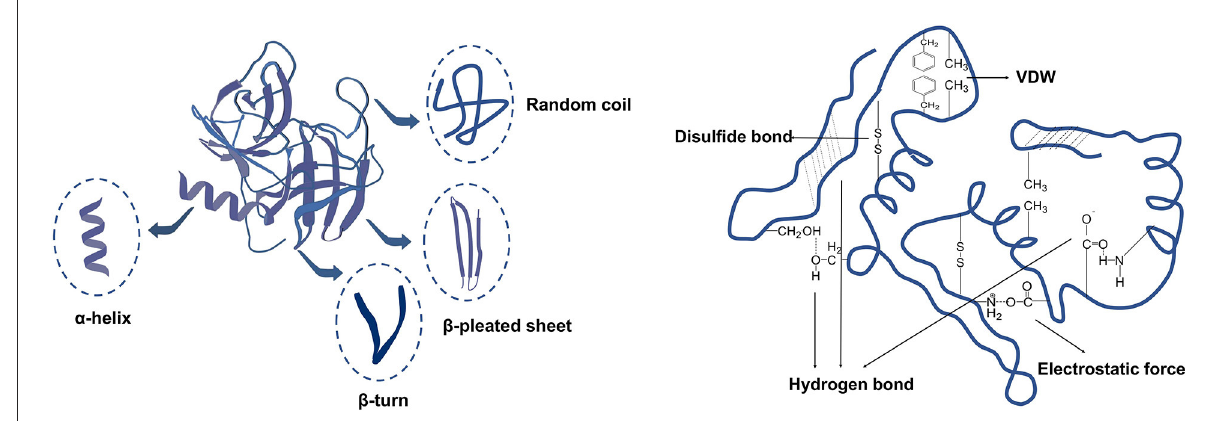
FIGURE8 Secondary structure and intramolecular forces of proteins.